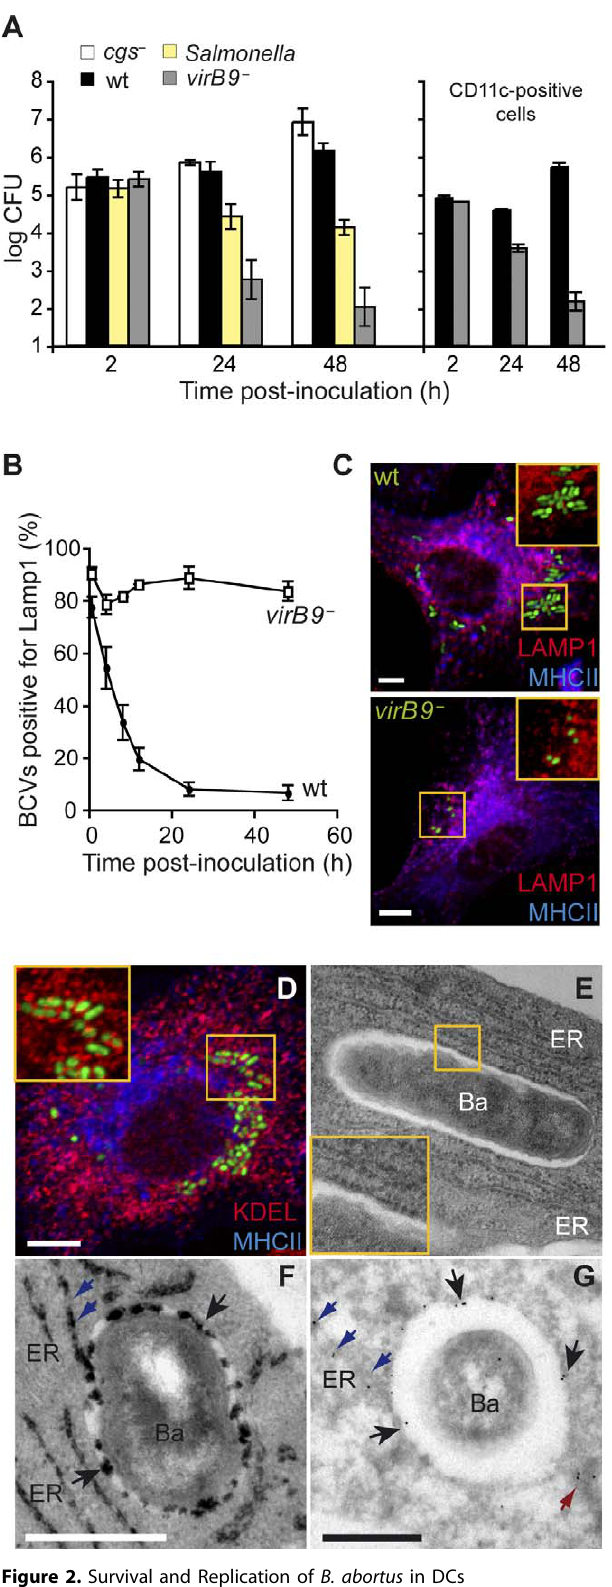
Figure 2. Survival and Replication of B. abortus in DCs (A) BMDCs infected with wild-type B. abortus , cgs (cid:2) mutant, virB9 (cid:2) mutant or the wild-type S. typhimurium were lysed and intracellular CFUs enumerated at different times after inoculation. Graph on the right corresponds to bacterial CFU counts performed in CD11c-positive cells infected with either wild-type B. abortus or virB9 (cid:2) mutant.